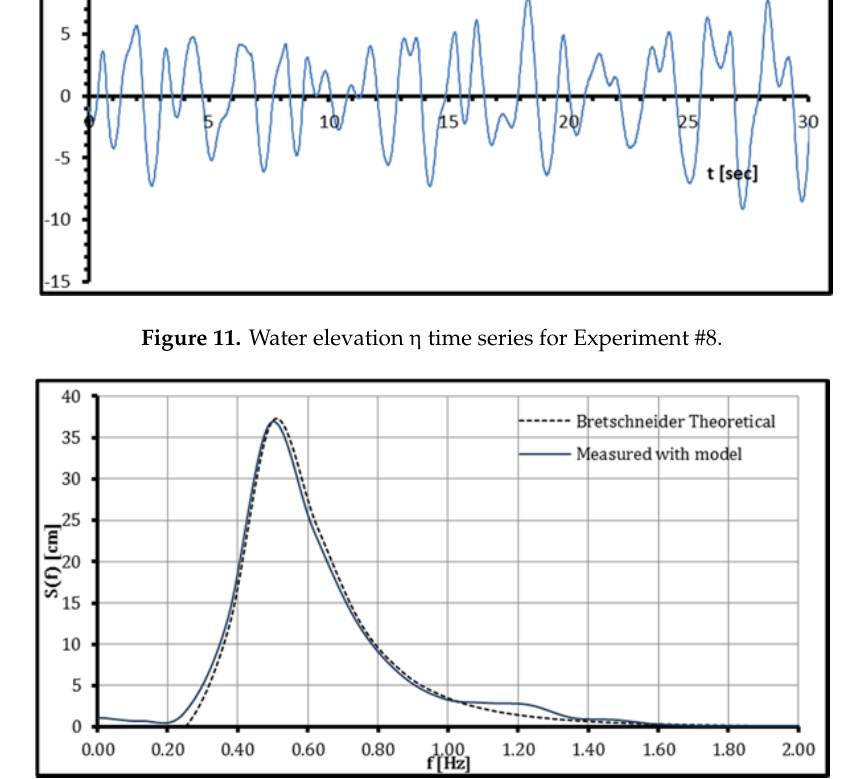
Figure 12. Power Density Spectrum, Bretschneider vs. Measured.